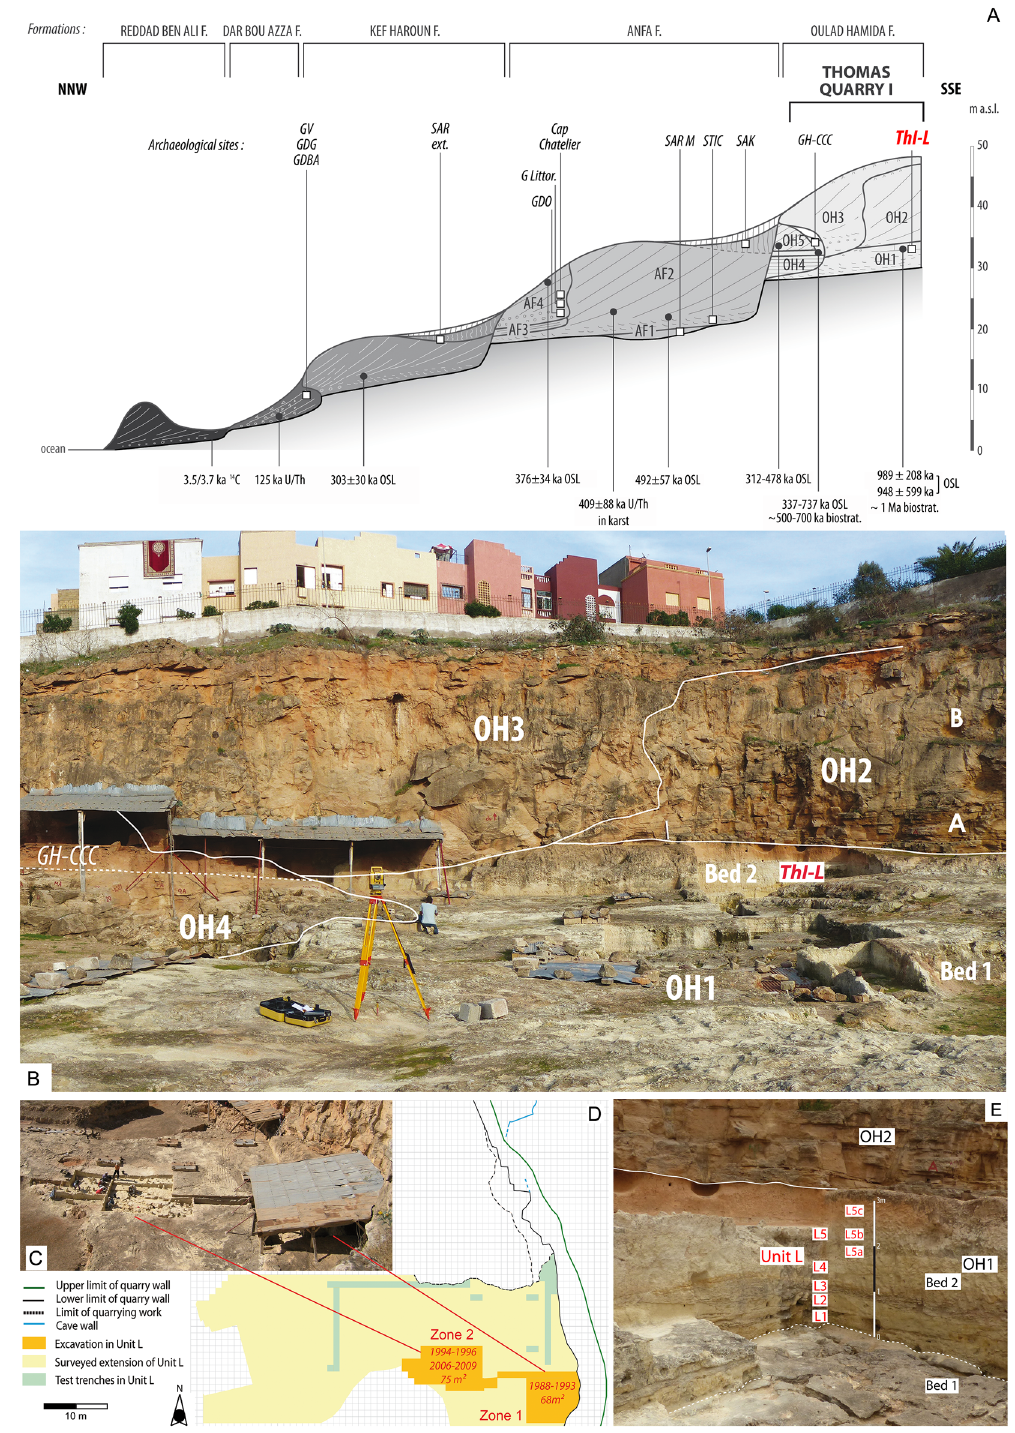
Figure 2. ( A ) OHF and its Members (late Early Pleistocene-Middle Pleistocene) exposed at Thomas and Sidi Abderrahmane quarries, South-West of Casablanca (drawing D. Lefèvre). Archaeological sites: GDBA: Grotte de Dar Bou Azza; GDG: